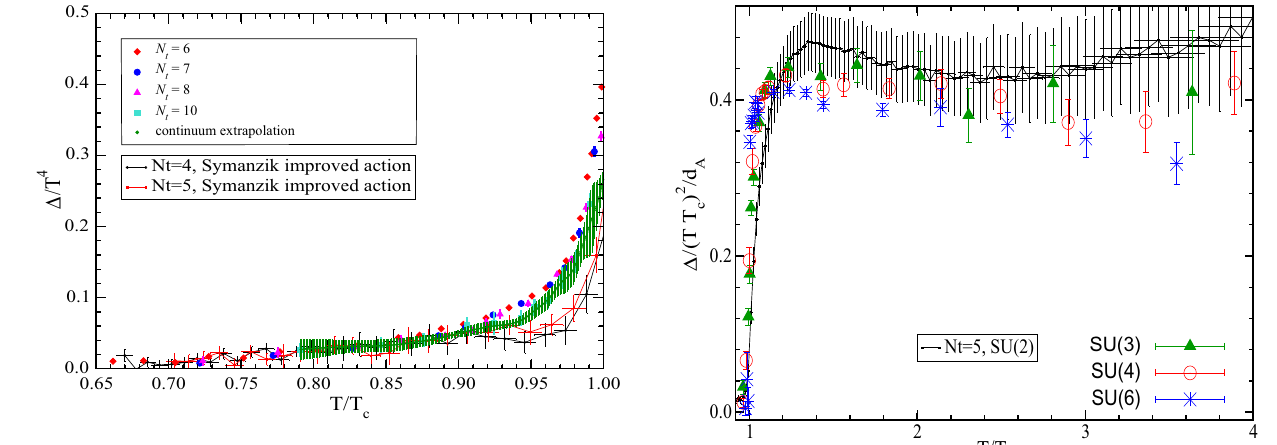
T / T c up to 2 T / T c the values for SU(2) are larger and not